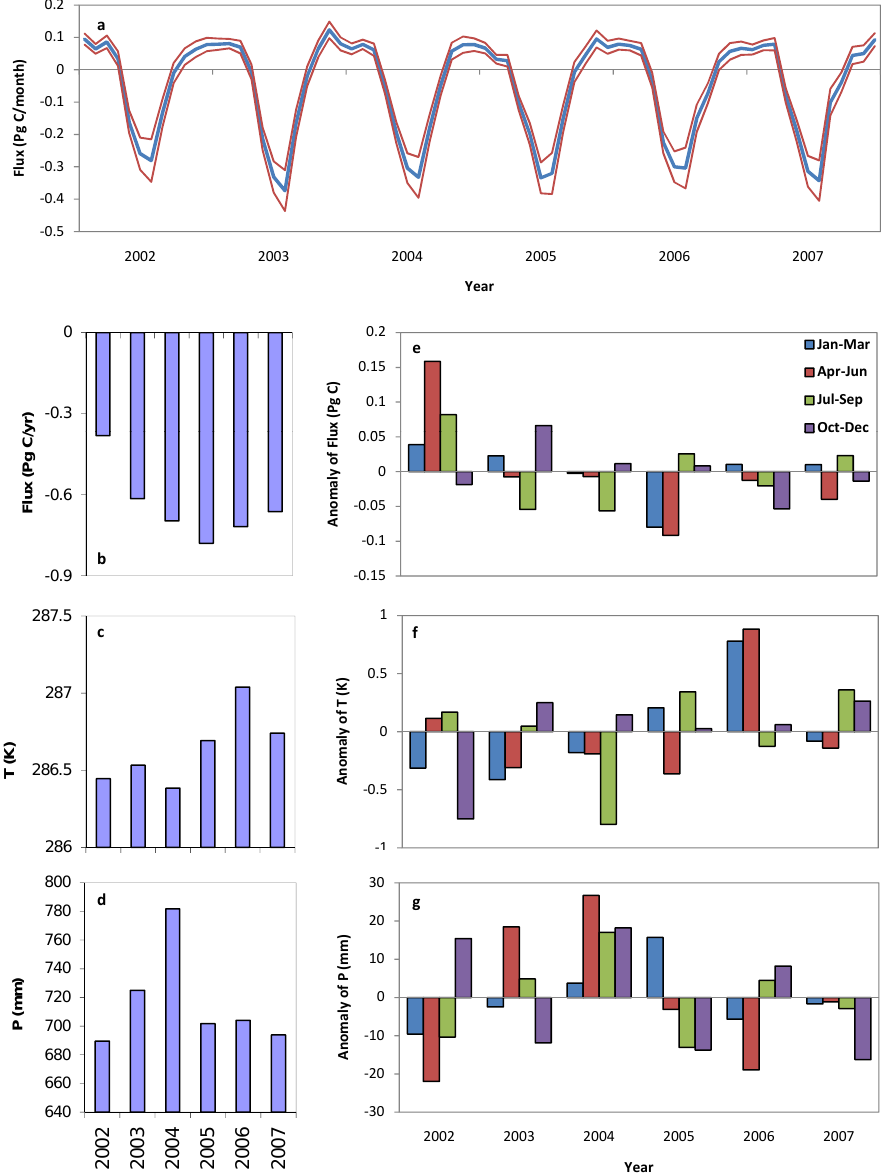
Fig. 7. The variations of inverted fluxes and climatic conditions from 2002 to 2007 in Region NA-S (Regions 18–30). (a) The inverted monthly fluxes (thick blue line) and their uncertainties (thin red line), (b) the inverted annual fluxes, (c) the annual mean temperatures, (d) the annual precipitations, (e) the 3-monthly anomalies of inverted fluxes, (f) the 3-monthly temperature anomalies, and (g) the 3-monthly precipitation